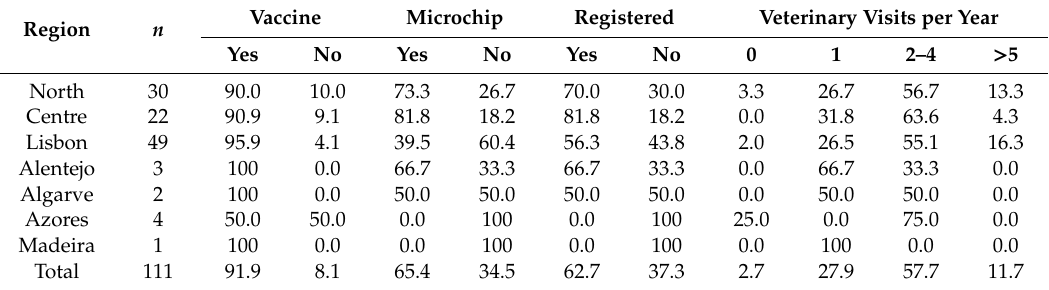
Table 5. Husbandry of Portuguese pets: vaccination status (%), identification with microchip (%), municipality registration (%), and veterinary visits per year